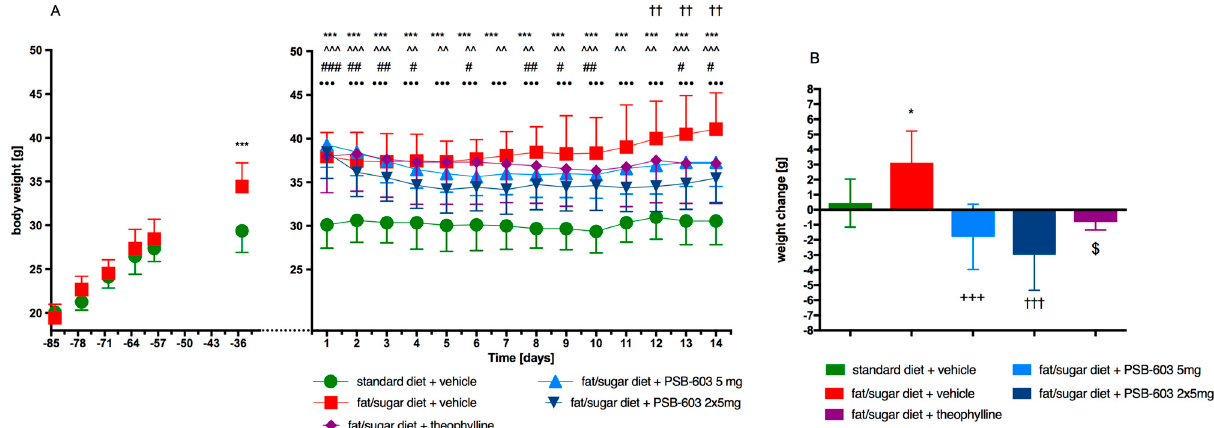
Figure 2. Effect of PSB-603 administration on body weight. ( A ) Body weight throughout the ad- ministration. ( B ) Sum of weight changes. Results are expressed as means ± SD, n = 8–10. Multiple comparisons were performed by two-way ANOVA, Tukey post hoc, ( A ) or one-way ANOVA Tukey post hoc ( B ). * Significant between control mice fed a standard diet and control mice fed a fat/sugar diet; ^ Significant between control mice fed a standard diet and mice treated with PSB-603 at a dose of 5 mg/kg b.w./day and fed a fat/sugar diet; # significant between control mice fed a standard diet and mice treated with PSB-603 at a dose of 2 × 5 mg/kg b.w./day and fed a fat/sugar diet; • significant between control mice fed a standard diet and mice treated with theophylline at a dose of 2 × 50 mg/kg b.w./day and fed a fat/sugar diet; + significant between control mice fed a fat/sugar diet and mice treated with PSB-603 at a dose of 5 mg/kg b.w./day and fed a fat/sugar diet; † significant be- tween control mice fed a fat/sugar diet and mice treated with PSB-603 at a dose of 2 × 5 mg/kg b.w./day and fed a fat/sugar diet; $ significant between control mice fed a fat/sugar diet and mice treated with theophylline at a dose of 2 × 50 mg/kg b.w./day and fed a fat/sugar diet; *, #, $ p < 0.05, ^^, ##, †† p < 0.01, ***, ^^^, +++, †††, •••, ### p < 0.001.